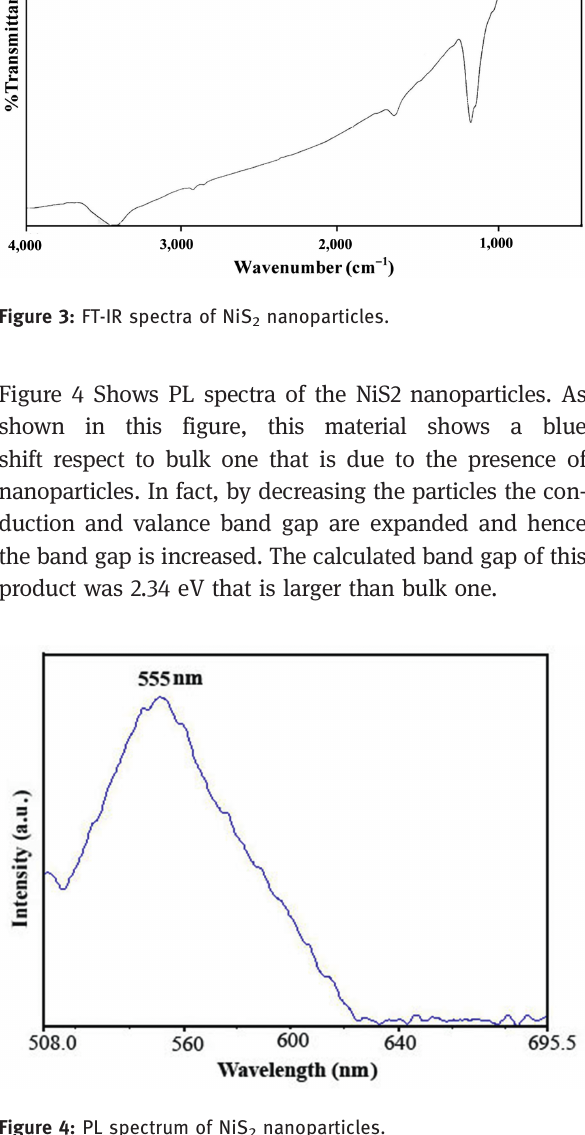
Figure 4: PL spectrum of NiS 2